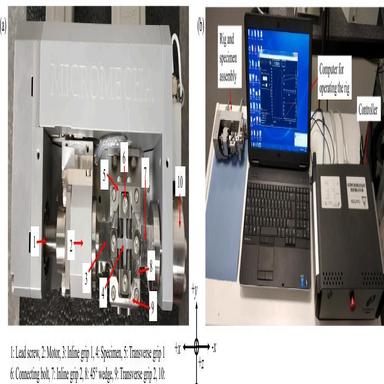
Experimental set-up consisting of (a) the Micromecha Proxima rig and the specimen; and (b) all other accessories.